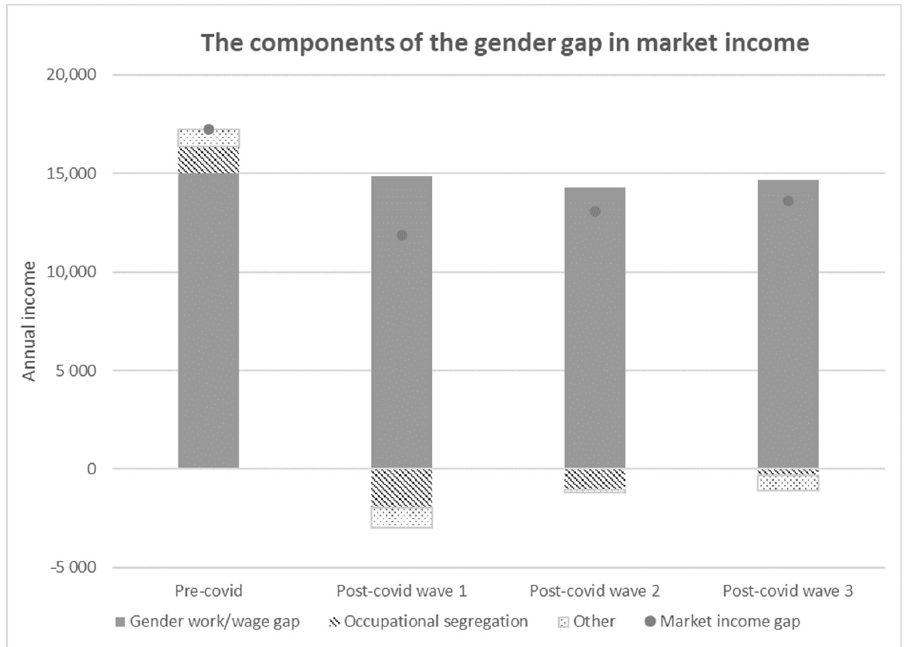
Figure 5. The components of the gender gap in market income. Source: Own calculations using the NUI Galway microsimulation model linked to 2017 SILC data nowcasted to December 2019 (pre-COVID), May 2020 (wave 1), October 2020 (wave 2) and January 2021 (wave 3). Sample is ≥ 18. Notes: The gender work/wage gap, occupational segregation gap and other gap correspond to the three terms in equation 1 in Section 4.4.2.